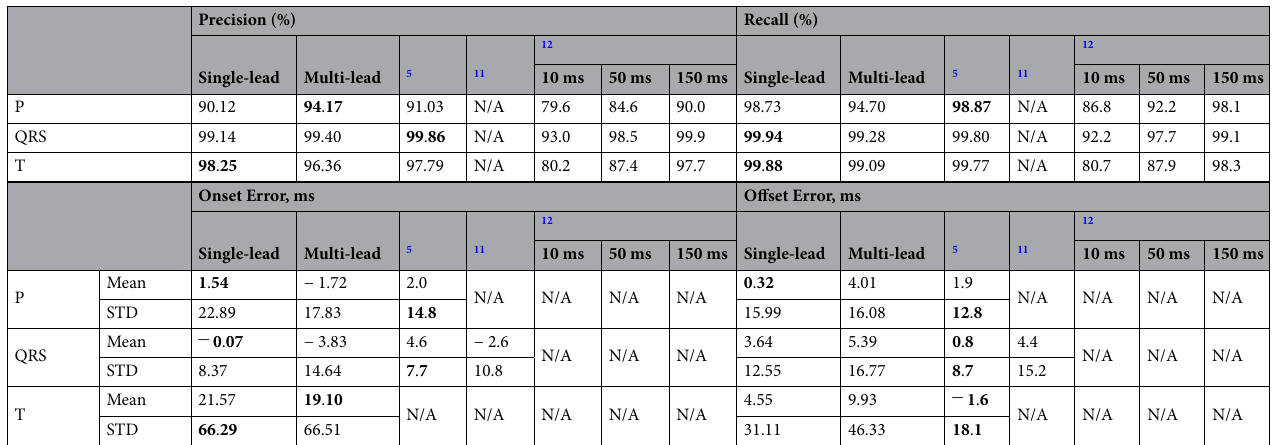
Table 2. Precision and recall ( % ; top) and onset and offset errors (mean, M ± standard deviation, SD; bottom) of our best performing single-lead model as compared to other approaches. Sodmann et al. 12 reports results for different window sizes (10, 50, 150 ms), considering a true positive if their prediction is contained within the window. N/R stands for “not